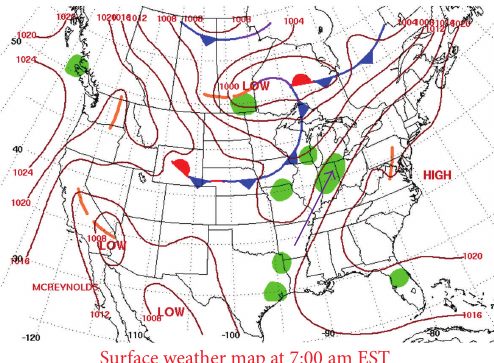
Figure 7: A weather map on June 18, 2006, at 7:00 am EST. The contour lines show the surface pressure and green areas are with precipitation. Fronts are in blue and red. The arrow indicates direction of winds. “High” or “Low” indicates a high pressure (anticyclone) or low pressure (cyclone)